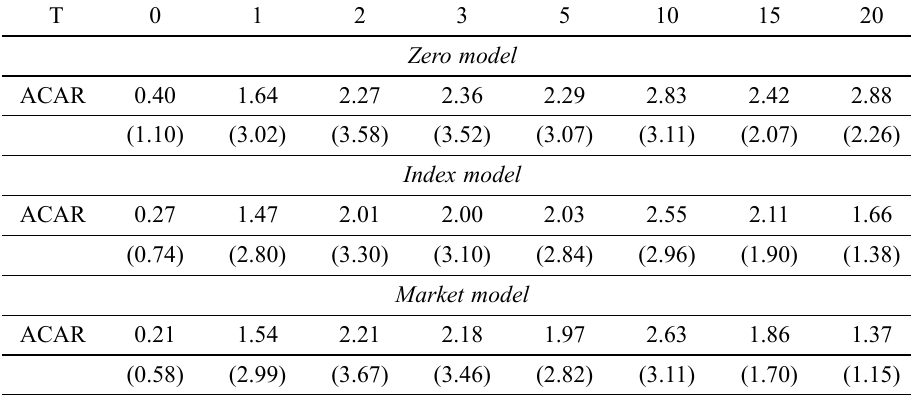
Table 1. Short-term abnormal returns on acquiring